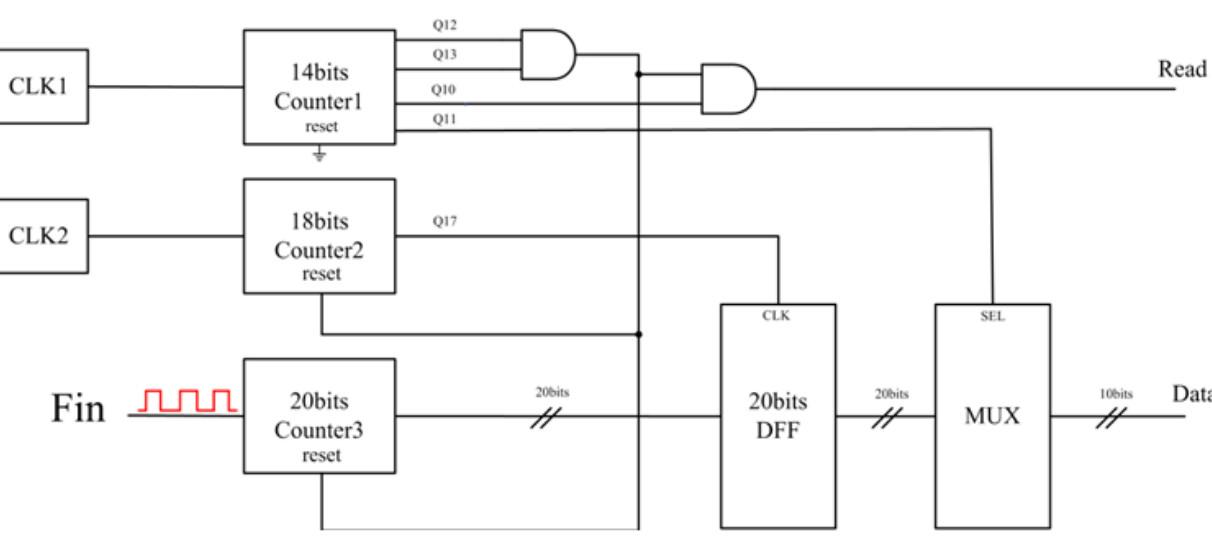
Figure 6. Schematic of digital frequency readout